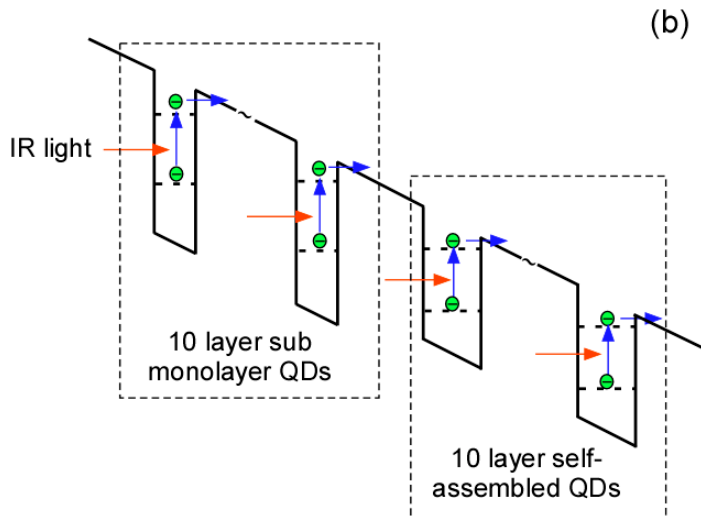
Figure 1. ( a ) Schematic structures of the hybrid Quantum-dot infrared photodetector (QDIP). It consists of the Submonolayer (SML) QDs and self-assembled QDs sandwiched between the top and the bottom contacts. ( b ) Simplified conduction band structure of the SML and self-assembled QDIP. Due to the different energy levels, the SML and self-assembled QDs can detect different bands.